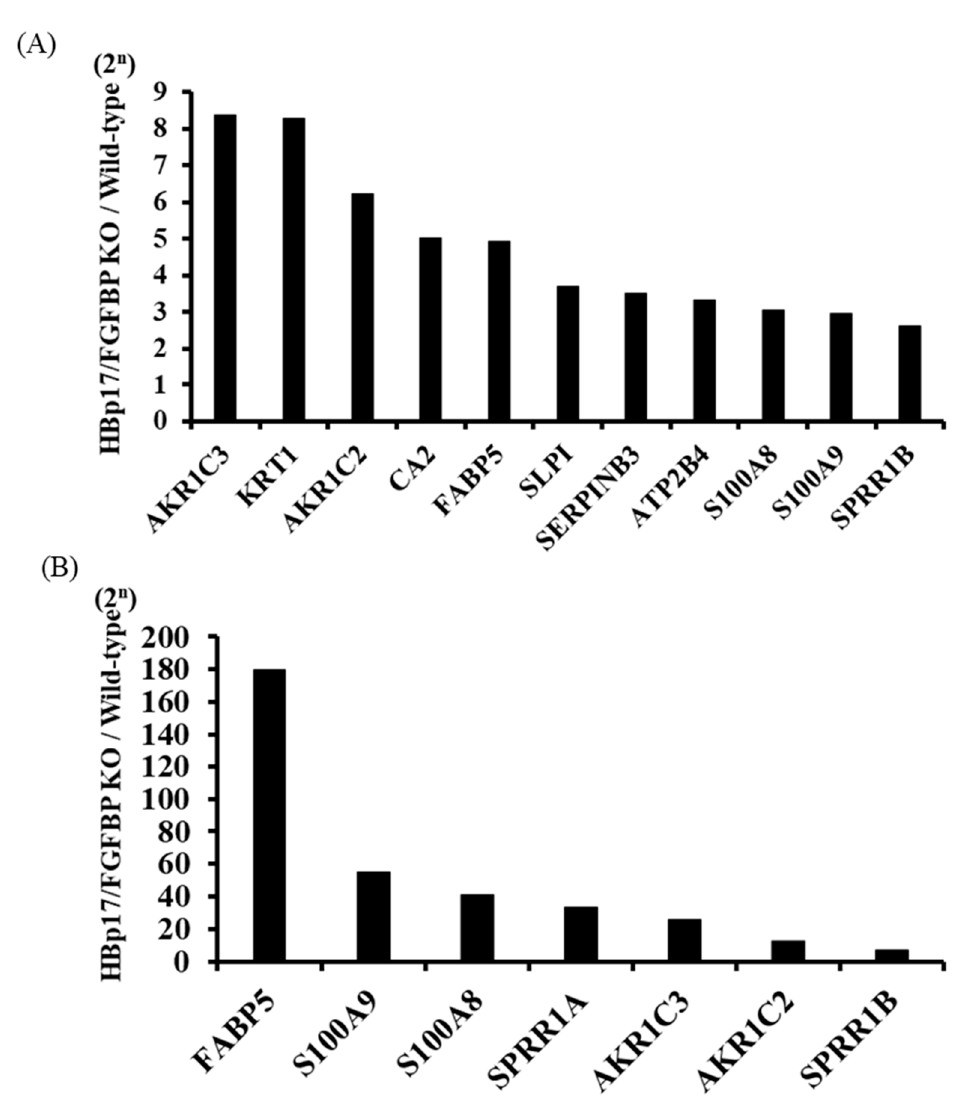
Figure 6. cDNA microarray and proteomic analyses of A431-HBp17-KO2 and A431-WT cells. ( A ) cDNA microarray analysis found 11 cDNAs with greater than 2.5-fold higher expression in A431-HBp17-KO2 cells than in A431-WT cells. ( B ) Seven proteins were found to be expressed at least five times higher in A431-HBp17-KO2 cells than in A431-WT cells. Abbreviations: aldo-keto reductase family 1 member C3 (AKR1C3), keratin1 (KRT1), aldo-keto reductase family 1 member C2 (AKR1C2), carbonic anhydrase 2 (CA2), fatty acid-binding protein 5 (FABP5), secretory leukocyte protease inhibitor (SLPI), serine proteinase inhibitor clade B member 3 (SERPINB3), plasma mem- brane calcium-transporting ATPase 4 (ATP2B4), S100 calcium-binding protein A8 (S100A8), S100 calcium-binding protein A9 (S100A9), small proline-rich protein 1B (SPRR1B), and small proline-rich protein 1A (SPRR1A). Table 1. Top 10 GO terms of upregulated DEGs.